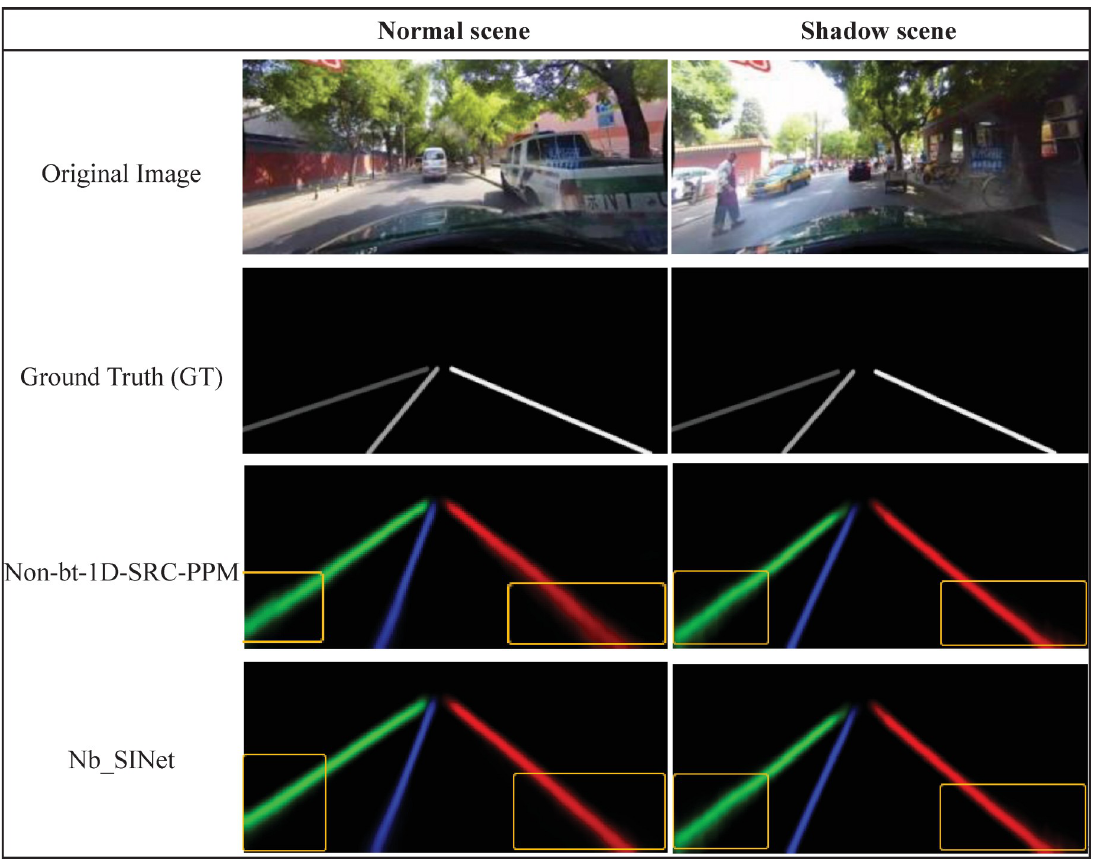
Fig 9. Semantic segmentation diagram of lane